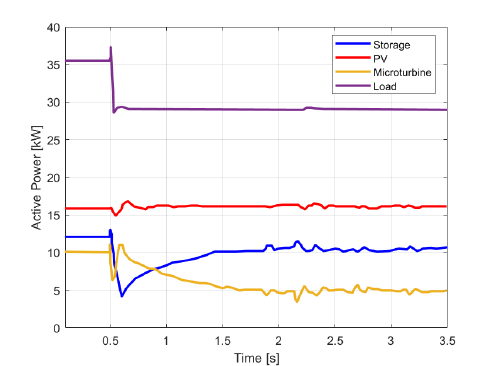
Figure 13. Simulation C: Active